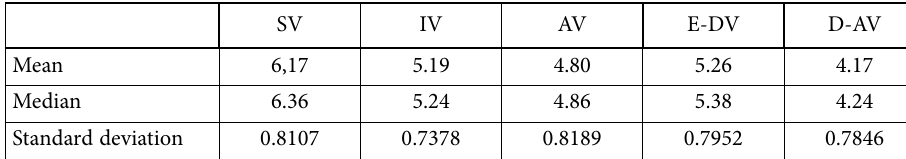
Table 2. Means and standard deviation of factor scores (source: own, 2018)